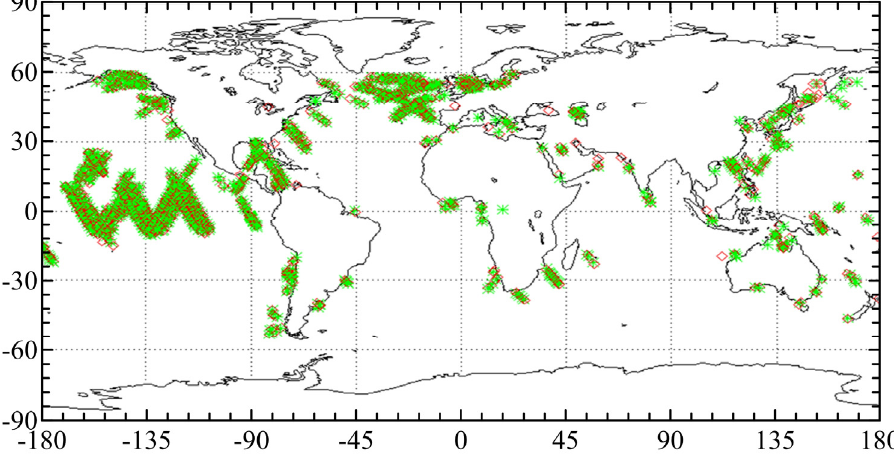
Figure 2. Schematic of the locations of the 2465 X-SAR images used for developing the Geophysical Model Function (GMF). The red and green marks represent the two independent